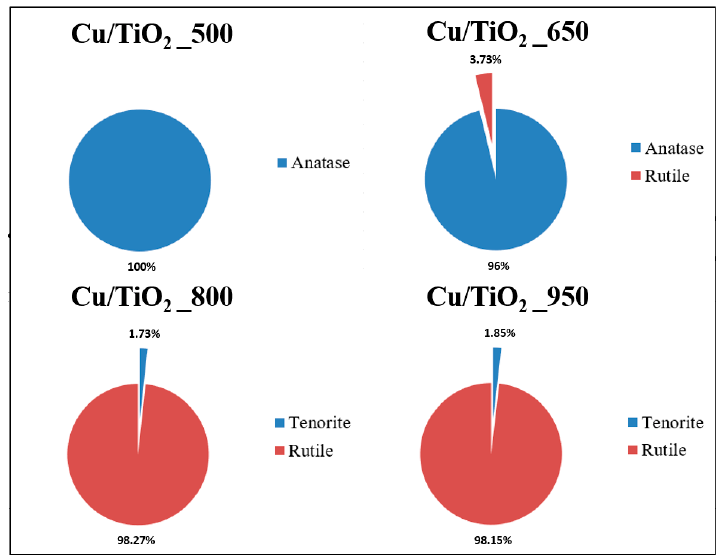
Figure 2. Percentage charts of phases in Cu/TiO 2 _500, Cu/TiO 2 _650, Cu/TiO 2 _800 and Cu/TiO 2 _950. Samples in each stage of annealing temperature.